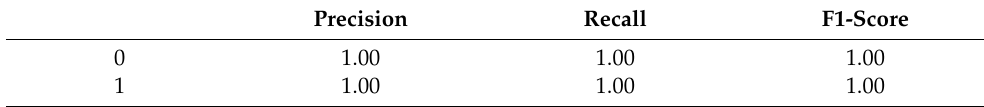
Table 11. Performance Metrics for Testing Data.